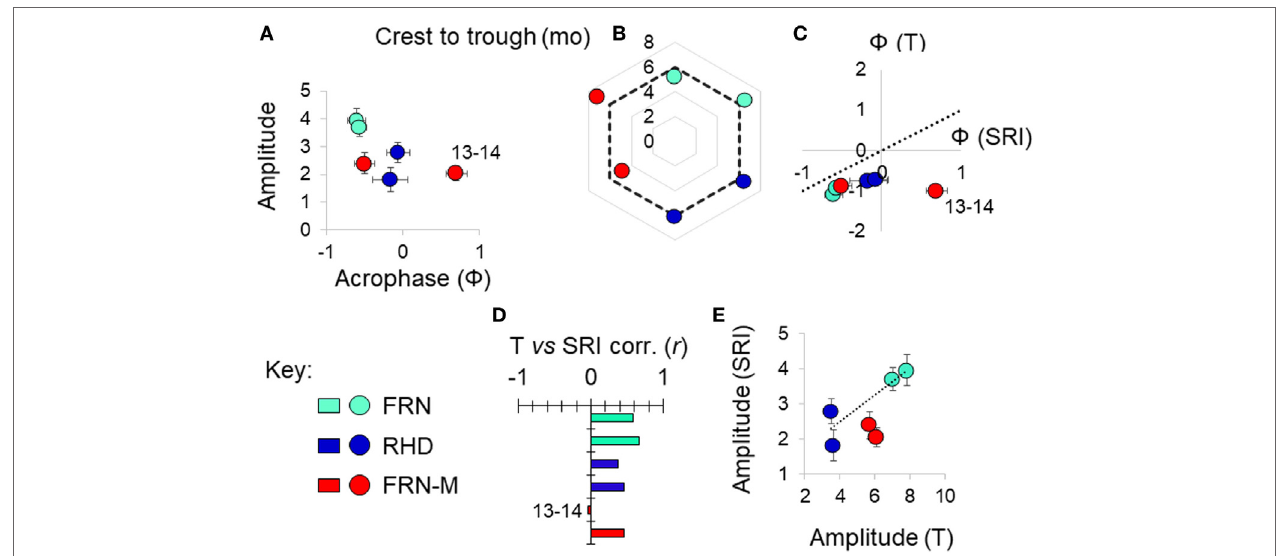
FigUre 5 | Variation in seasonal immune-associated gene expression in wild (FRN, RHD) and mesocosm (FRN-M) habitats in 2013–2014 and 2014–2015. Based on a seasonal reporter index (SRI) of expression in 12 genes. (a) Scatterplot of sinusoid amplitude and acrophase ( Ф ) of SRI variation estimated by confounder- adjusted cosinor regression; whiskers indicate 1 SE either side of estimate. (B) Asymmetry in the seasonal fluctuation. Radar plot shows delay between early and late season inflection points (determined graphically based on non-parametric smoother from confounder-adjusted generalized additive mixed model analysis). Dotted line indicates the symmetrical expectation given sinusoid variation; for each site, 2014–2015 points clockwise of 2013–2014 points; mo, months. (c) Scatterplot of acrophase for thermal variation (T) vs acrophase for SRI variation; estimates from confounder-adjusted cosinor regressions; whiskers indicate 1 SE either side of estimate. Where points are below the dotted line (T Ф = SRI Ф ), there is an earlier peak for temperature than for SRI. (D) Pearson correlation coefficients (corr., r ) between SRI and temperature (mean for the week prior to sampling). (e) Scatterplot of amplitude for SRI vs amplitude for thermal variation (°C); estimates from confounder-adjusted cosinor regressions; whiskers indicate 1 SE either side of estimate. Dotted line joins centroids for the two wild sites, for reference. (a–e) Sites: FRN, upland lake; RHD, lowland river side-channel; FRN-M, semi-natural mesocosms stocked with wild-caught fish from FRN. For each site, a separate datum is plotted for each study year; outlying values for FRN-M in 2013–2014 are indicated (“13–14”).